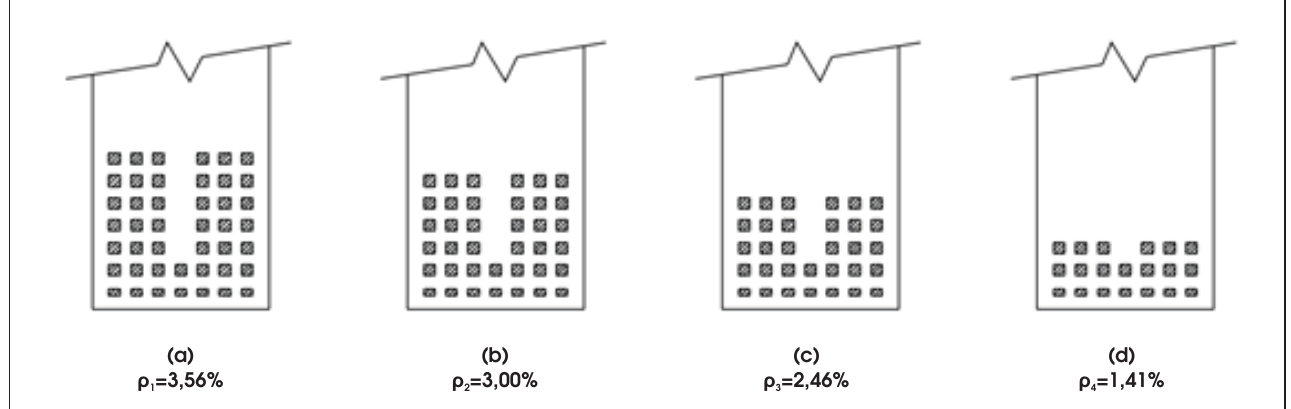
Figure 10 – Distribution of bars in the cross section of the longitudinal beam, with 40% of corrosion in the first layer of (MENDES [1] )